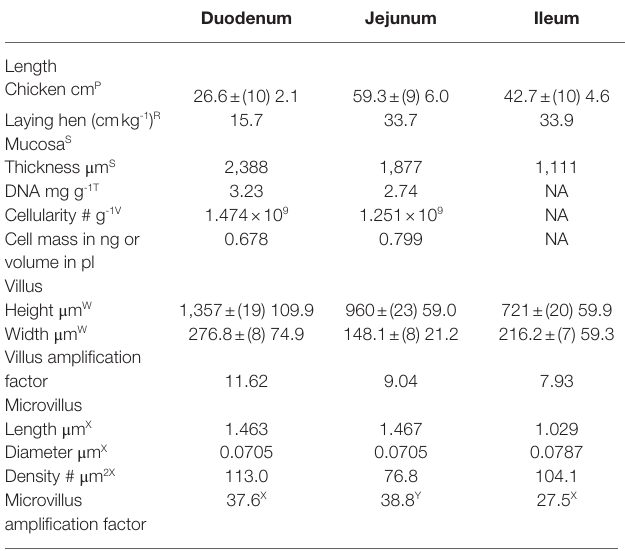
TABLE 4 | Differences in reproductive and other parameters between sexually TABLE 5 | Small intestine parameters in laying hens [mean ± (number of studies) immature female chickens and laying hens. SEM]. Mean ± ( n = studies) SEM Immature females Laying hens